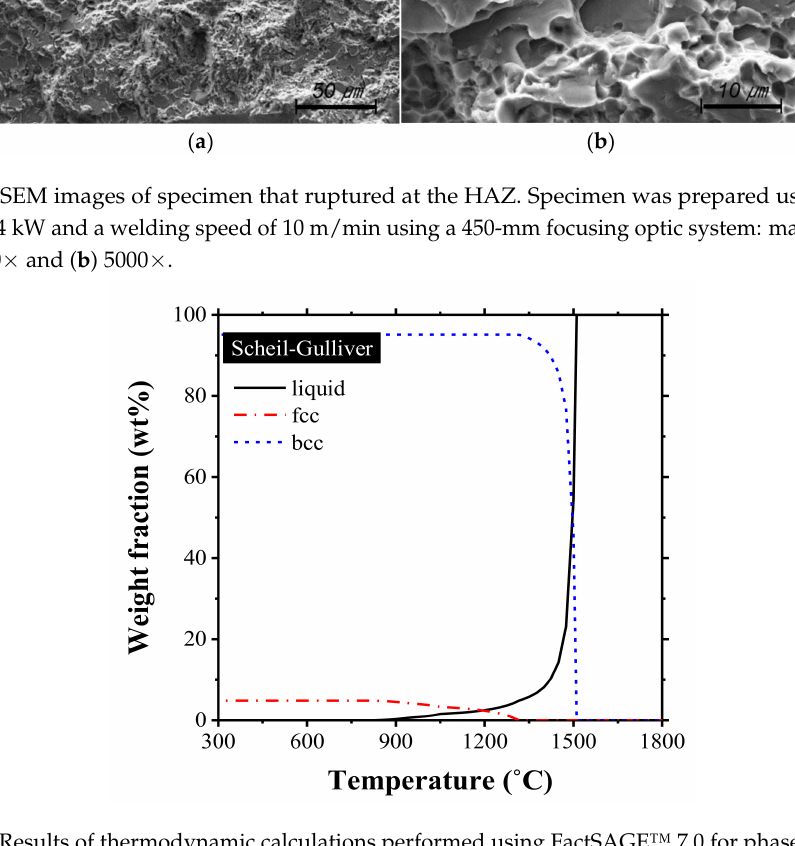
Figure 4. Results of thermodynamic calculations performed using FactSAGE™ 7.0 for phase formation during solidification under the Scheil–Gulliver